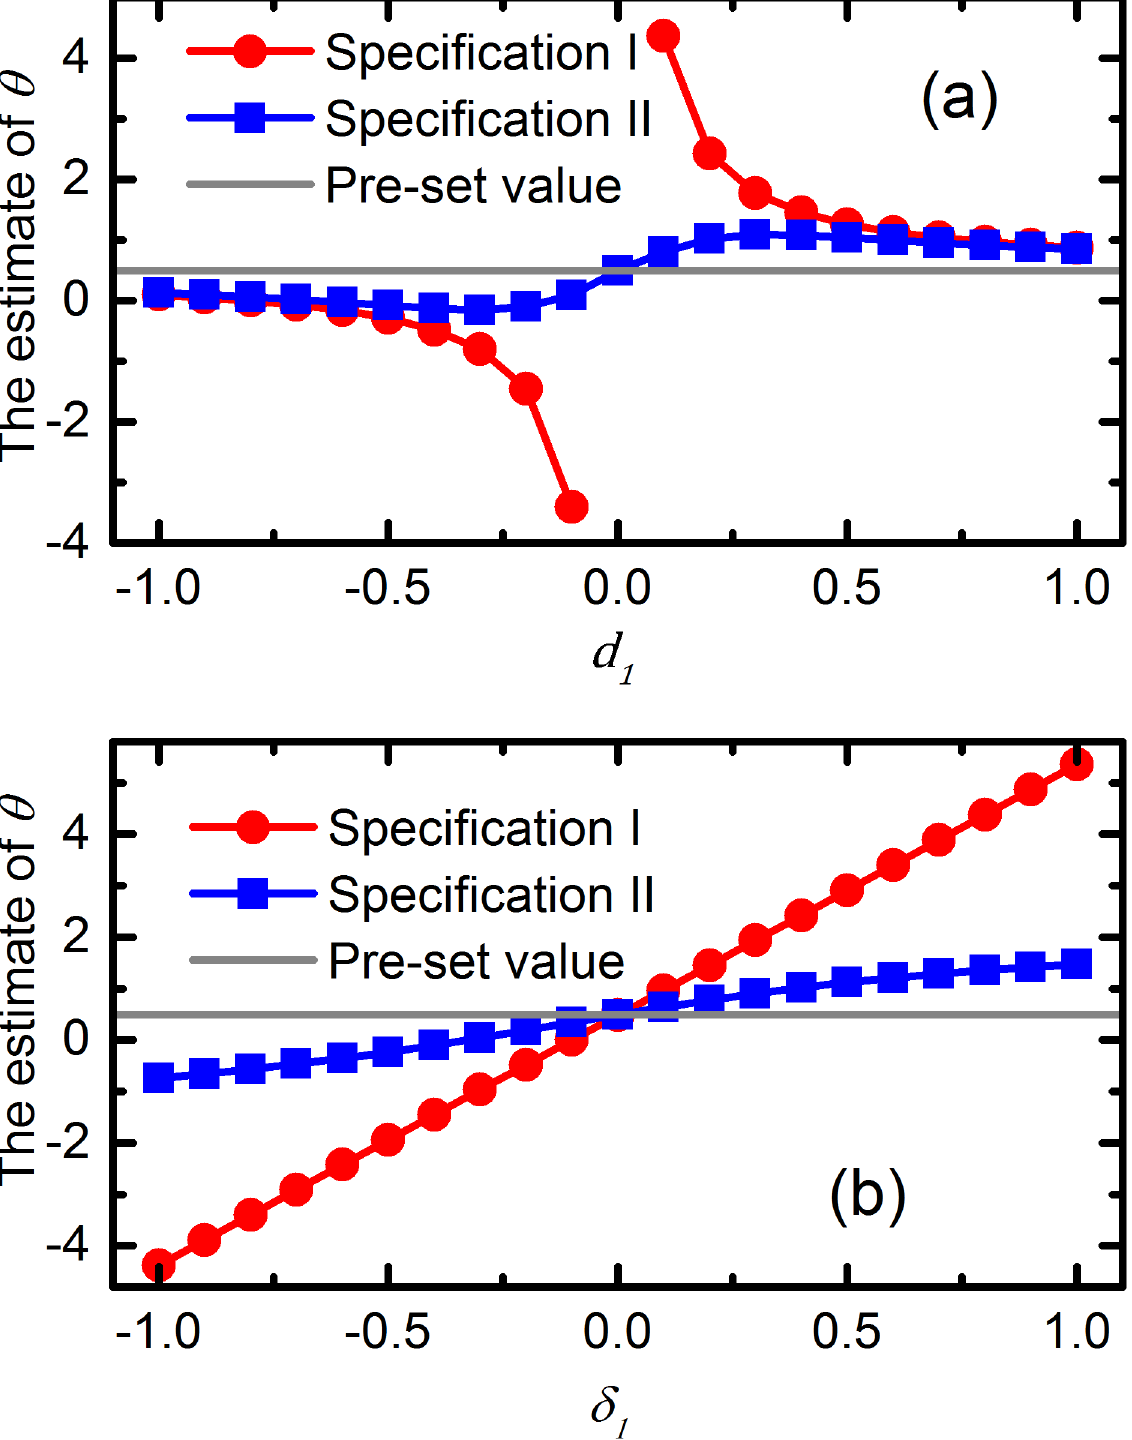
Fig 2. Estimates of the association between the 25(OH)D concentration and the health outcome ( Θ ) according to the change in (a) d 1 , with δ 1 = 0.4 and (b) δ 1 , with d 1 = 0.2; sample size 5000, Specification I and